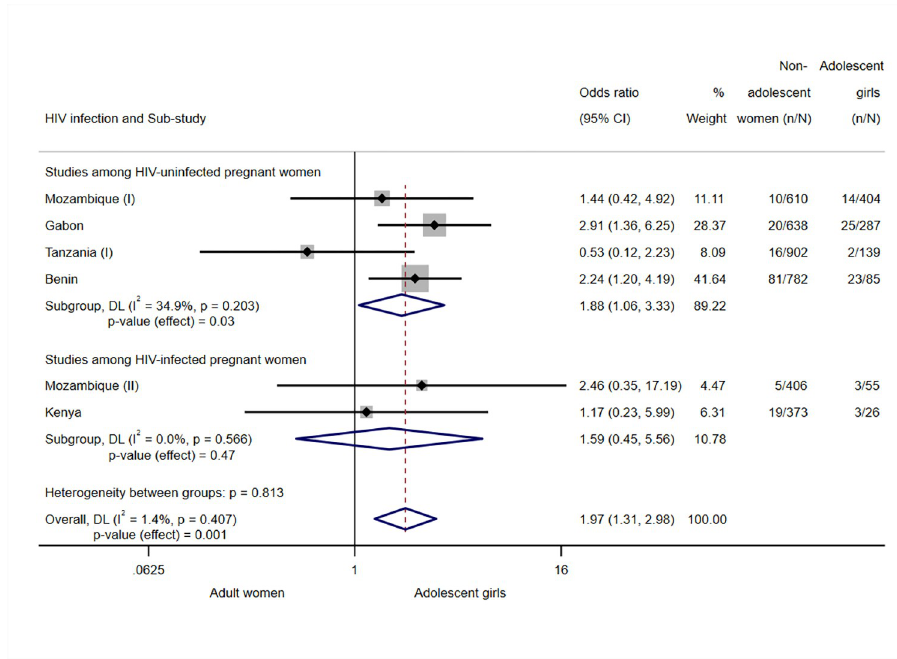
Fig 3. Analysis for placental malaria. Notes: Analyses adjusted by trial arm, gravidity, literacy, gestational age at recruitment, MUAC, anaemia at recruitment, adherence to the treatment (IPTp), and season at recruitment. Weights and between-subgroup heterogeneity test are from random-effects model. Tanzania (II), HIV-infected participants, was excluded from the analysis since no cases of placental infection were found among study participants in the site. CI, confidence interval; DL, DerSimonian–Laird random effects model; MUAC, mid-upper arm circumference; OR, odds ratio.